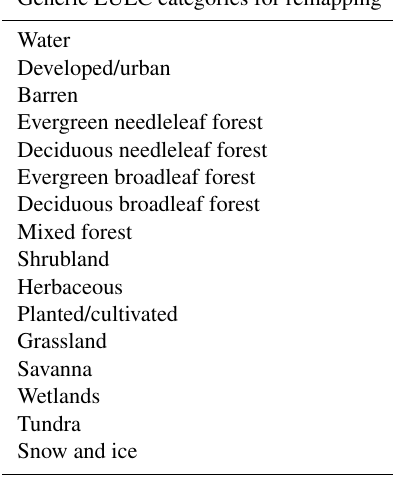
Table 3. Generic land use and land cover types for AQMEII4. Generic LULC categories for